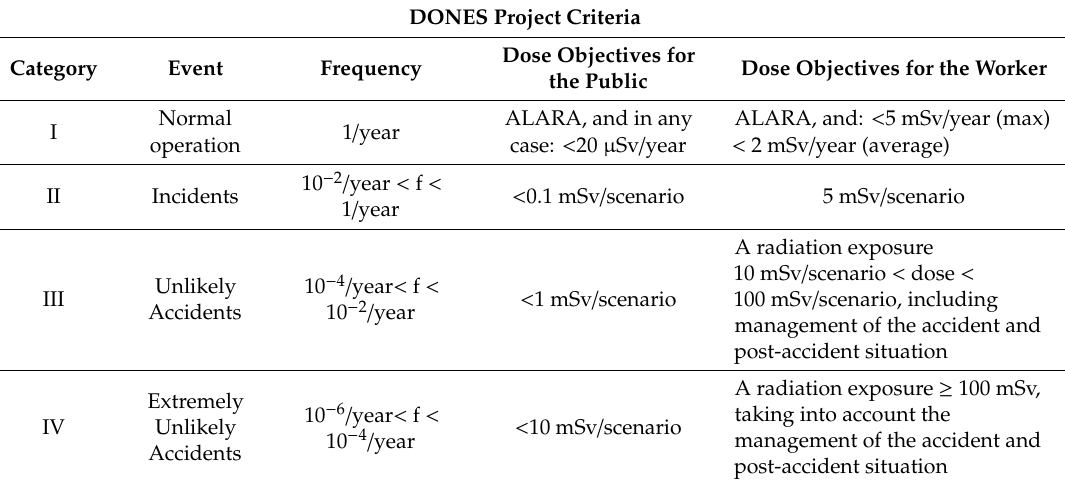
Table 3. Dose objectives for the public and workers.